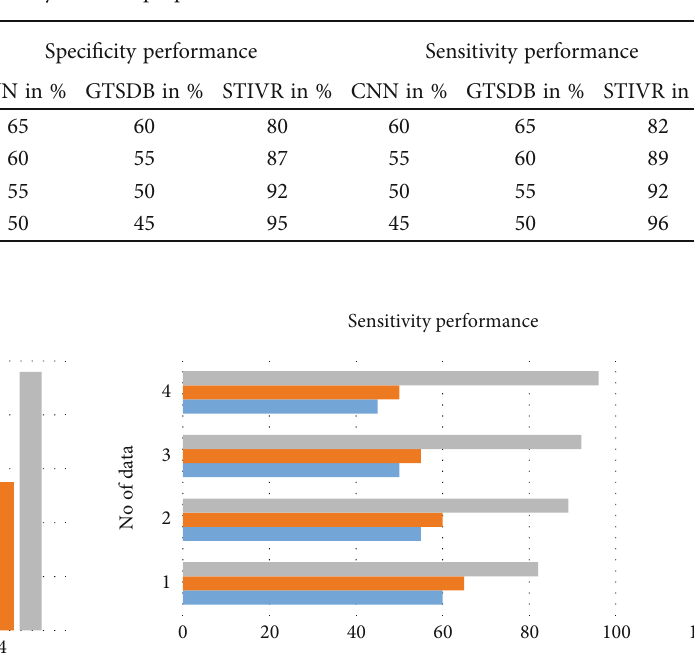
Table 2: The analysis of the proposed method.